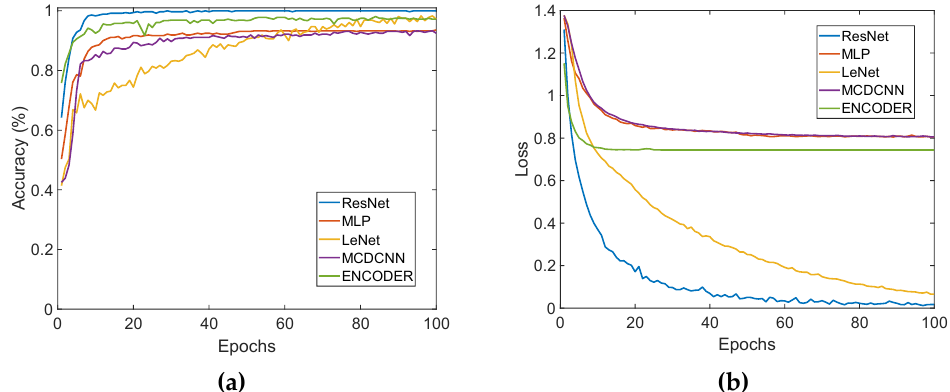
Figure 11. Learning curves of the five models based on four category samples: ( a ) The average accuracies of 4 hardness categories based on the five models; ( b ) Loss values of the five models.